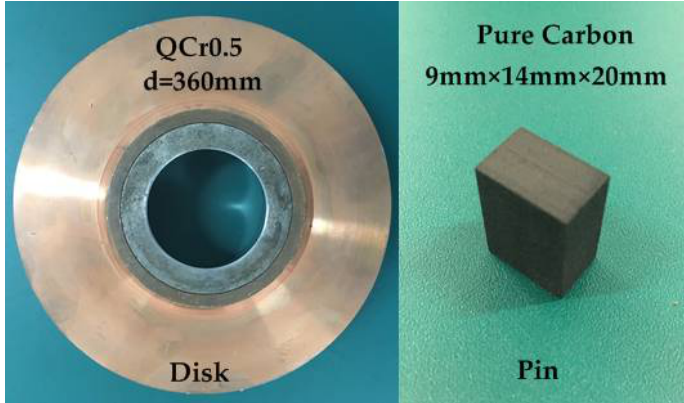
Figure 1. The QCr0.5 disk and the pure carbon pin.